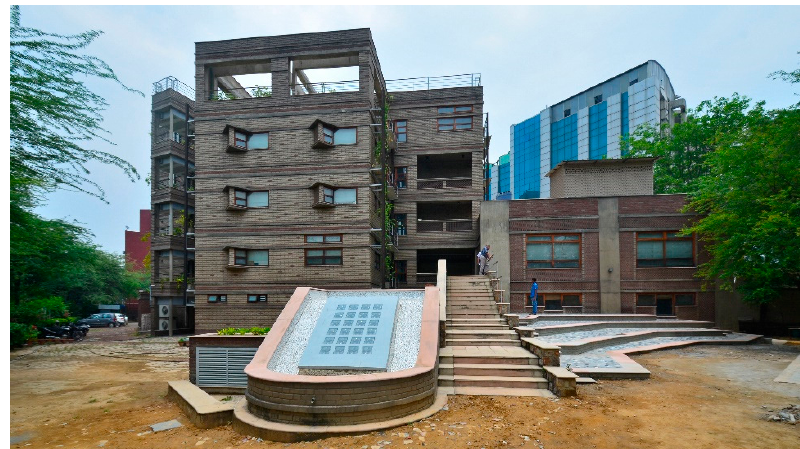
Figure 23. Earthy finish of the DA building in contrast with the neighbouring curtain-glass buildings visible in the background (Photo: Author).